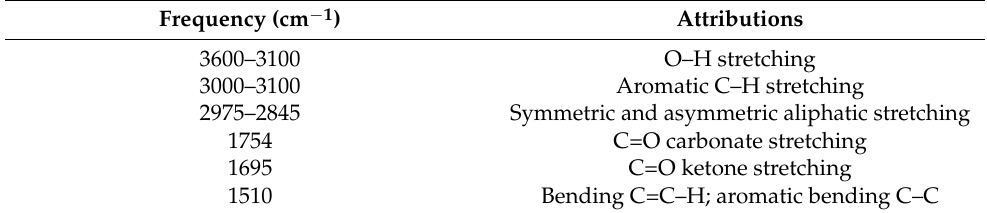
Table 2. Attribution of signals relating to the IR spectra in the Figure